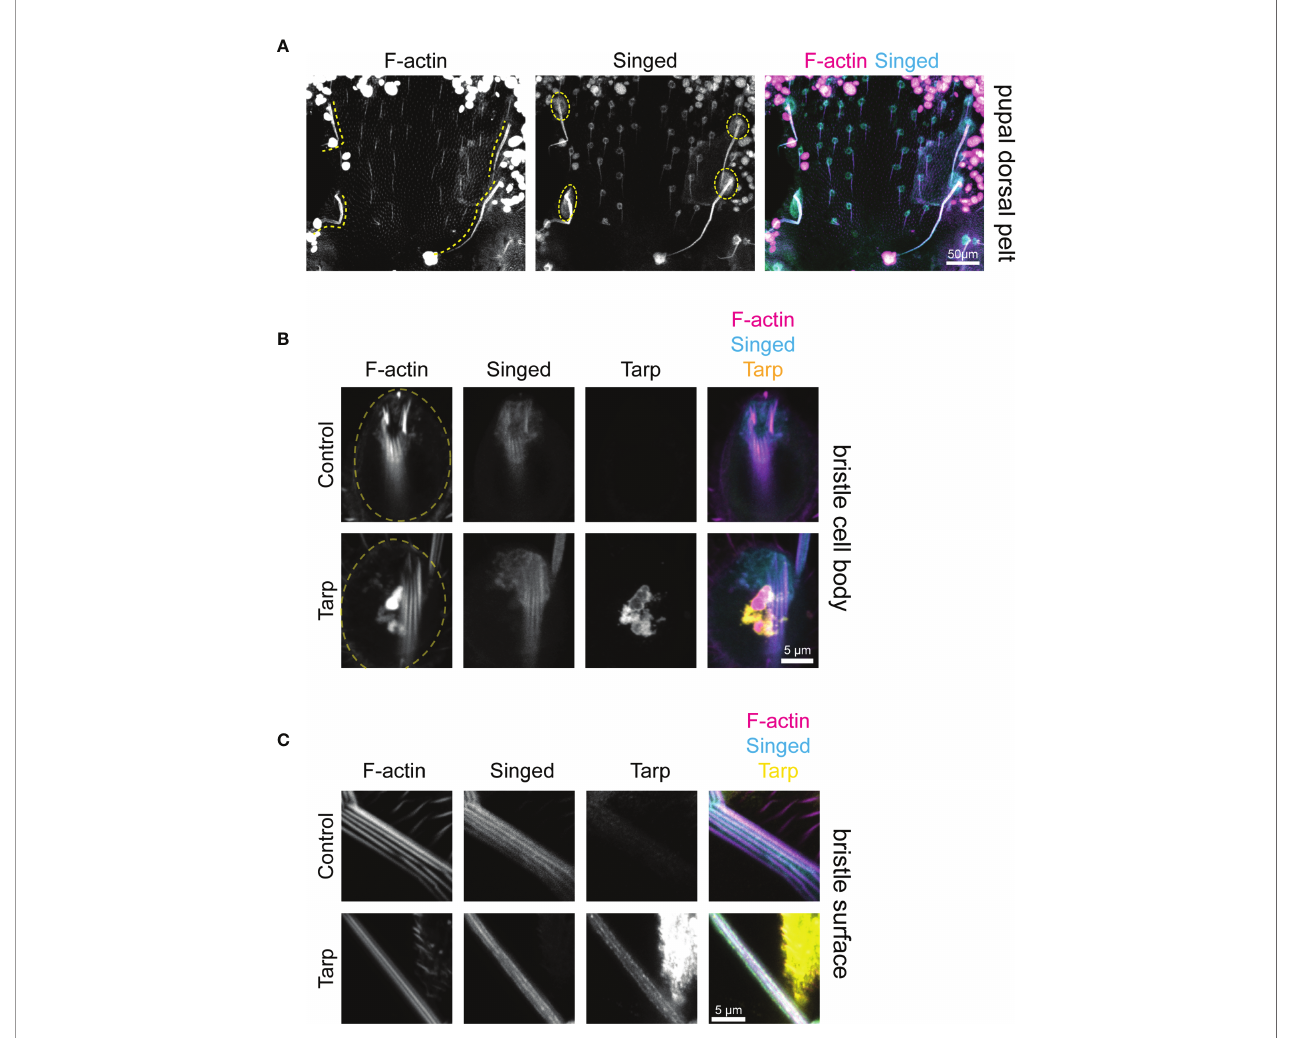
FIGURE 4 | Tarp is found within the growing bristle primordium during pupal development. (A) Confocal micrographs of a dissected dorsal pelt of control Drosophila pupa immunostained to visualize F-actin and Singed localization. Developing large mechanosensory bristles (yellow dashed lines) emerge from bristle cell bodies (yellow dashed circles). The number and topology of bristles are already determined at the pupal stage. (B) High-magni fi cation confocal micrographs of bristle cell bodies (yellow dashed circles) from control or Tarp-expressing pupae. Tarp is enriched in F-actin-abundant aggregates in the bristle cell body. F-actin bundles are found at the base of the bristle primordium. (C) Thin optical sections of high-magni fi cation representative confocal micrographs of developing pupal bristles from control (n=9) and Tarp-expressing (n=8) pupae. Longitudinally-arrayed F-actin bundles and Singed localization was observed for both genotypes. Tarp is similarly found within the growing bristle in Tarp-expressing fl ies. For all panels, Singed and Tarp localization was determined by immunostaining. F-actin was visualized using Alexa-conjugated phalloidin. Tarp expression was driven by